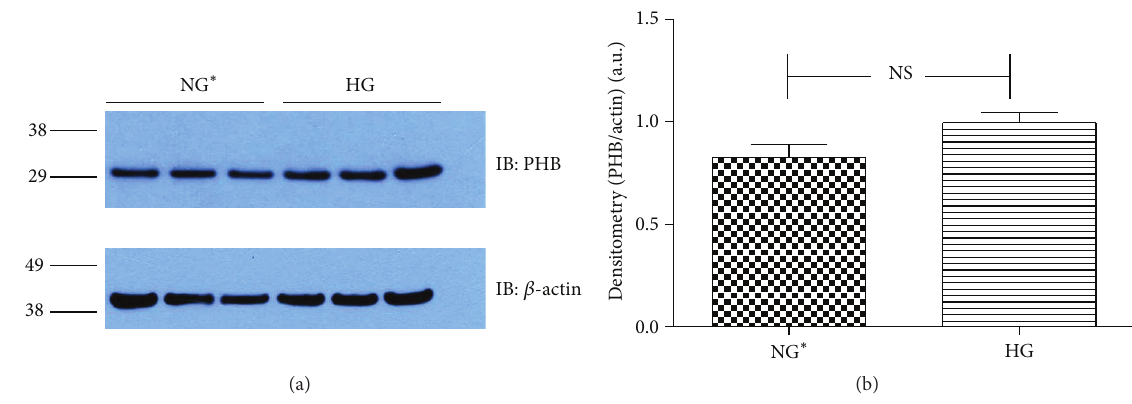
Figure 3: Validation of 2DE results for the enhanced PHB expression. Murine GMCs were cultured and treated for 2h with HG and NG ∗